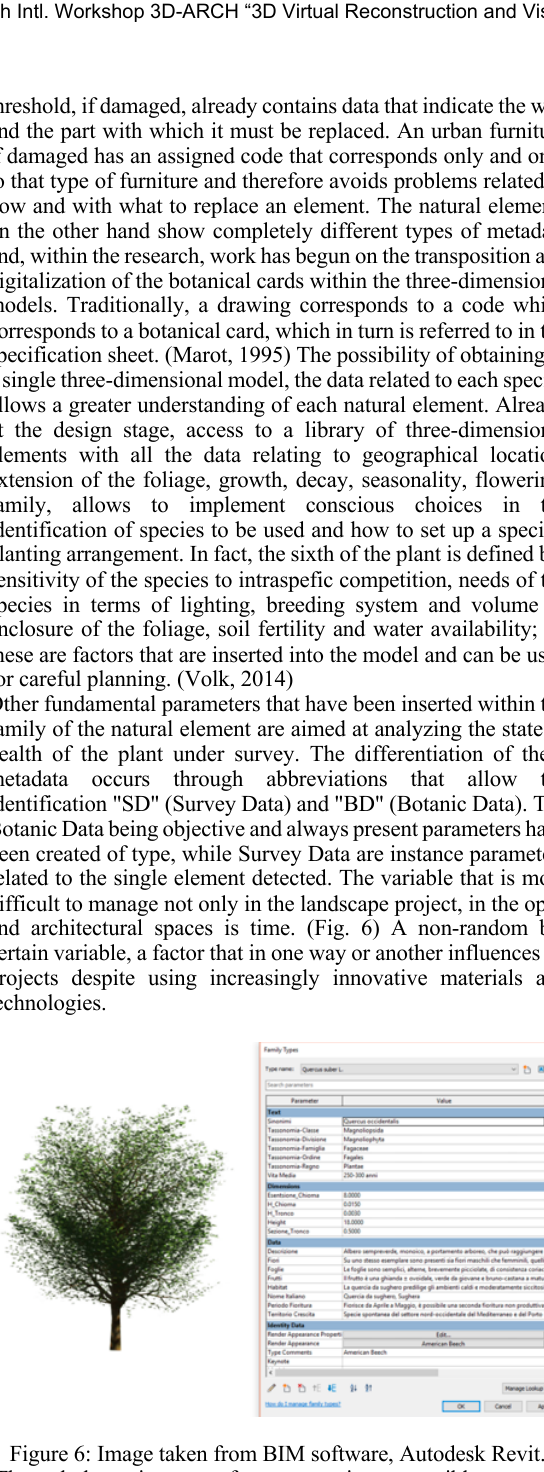
Figure 6: Image taken from BIM software, Autodesk Revit. Through the assignment of parameters it was possible to create a botanical card of type, table on the left. The botanical card of a cork was created in the